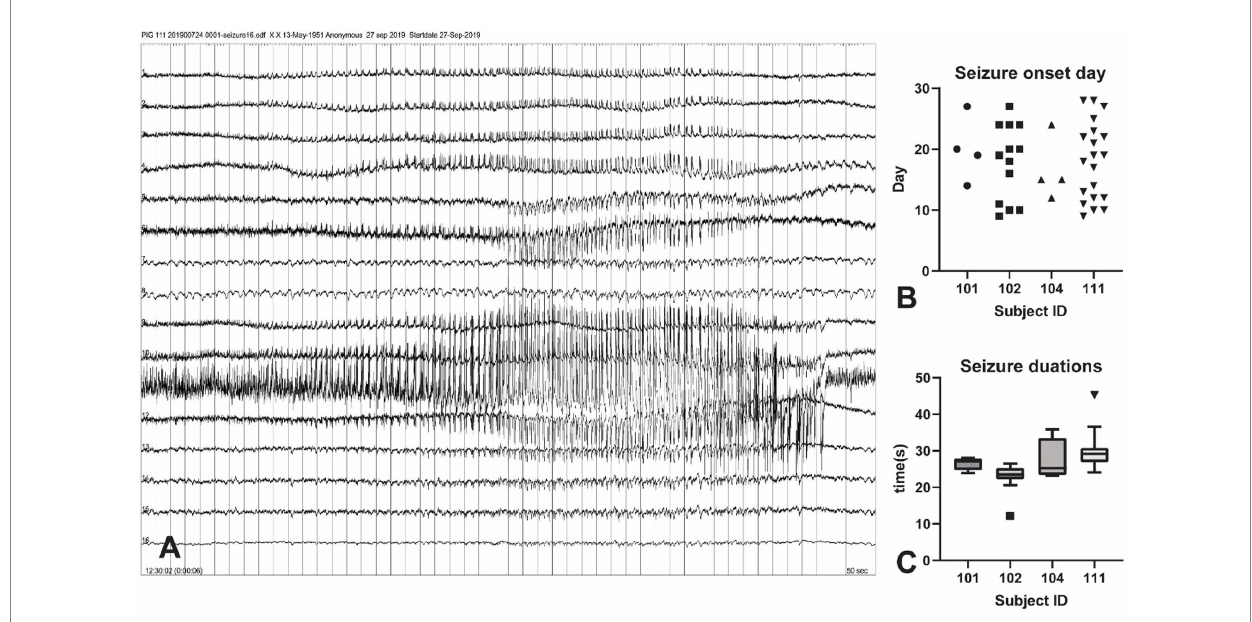
FIGURE 3 Seizure events in the KA-pig model of epilepsy. (A) Screenshot of a tonic–chonic electrophysiological seizures onset in an animal after KA injection. The onset is located in channel 11, later confirmed to be the right hippocampus. A total of 46 electrophysiological seizures were captured in the 4-week post-KA period from 4 animals (25% of the total). (B) The analysis of the seizure onset day. The earliest chronic seizure onset was observed in animal 111, on day 9 (shown in Figure A), and the last one was on day 27. The first seizure onset day is from 9–14 in these animals. (C) Seizure durations from all recorded 46 seizures in 4 pigs. The seizure duration ranged from 22 s to 35